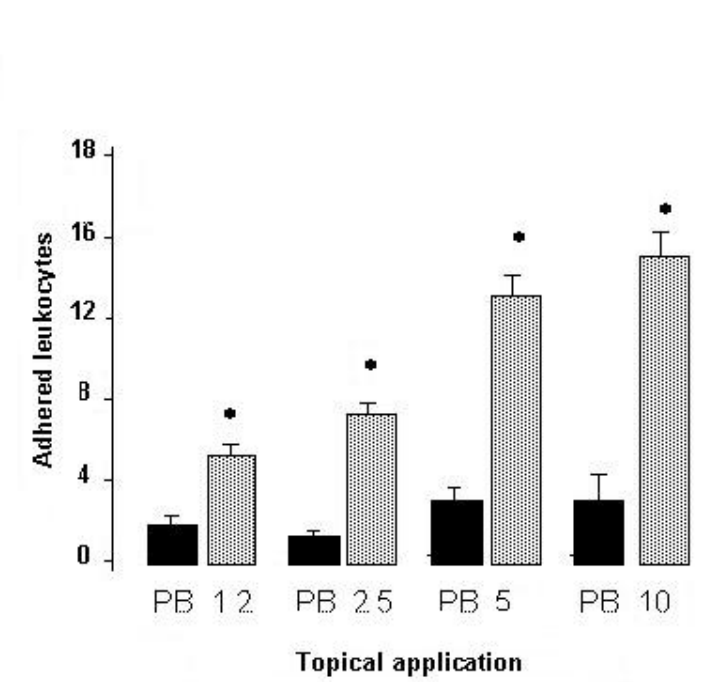
Figure 4. Evaluation of rolling (A) and adherent (B) leukocytes induced by C-type lectin from Bothrops jararacussu venom. Samples (30 μ l) containing different doses of lectin were topically applied on the cremaster muscle of anesthetized mice. The aspect of pre and postcapillary venules was observed after 30min. * p < 0.05, compared with control